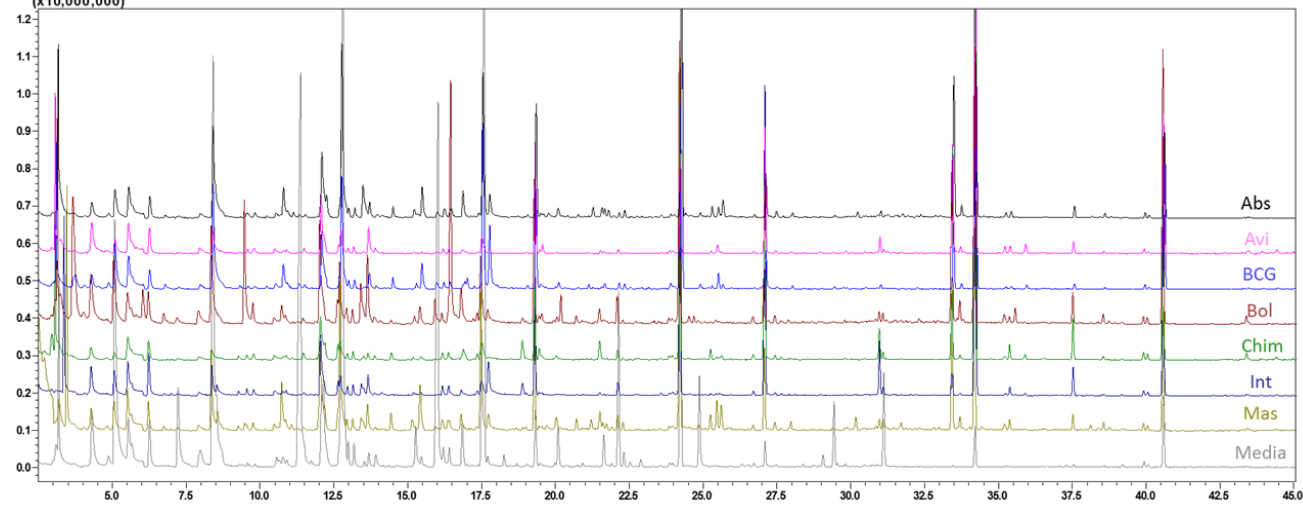
Figure 1. GC-MS total ion current (TIC) chromatogram obtained for the seven different mycobacteria and the medium. Abs — M. abscessus ; Avi — M. avium ; BCG — M. bovis ; Bol — M. bollettii ; Chim — M. chimaera ; Int: — M. intracellulare ; Mas — M. massiliense ; Media — growth media.